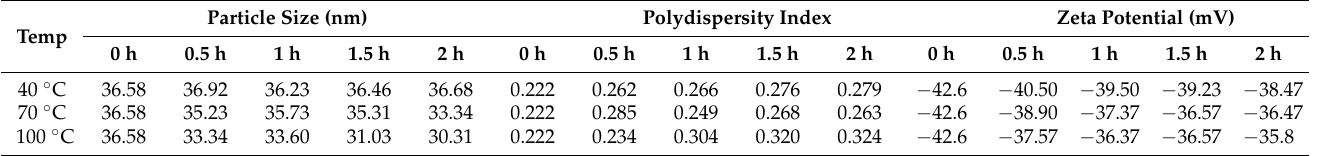
Table 7. The average particle size, polydispersity index and zeta potential changes in C. osmophloeum leaf nanoemulsion during storage for 90 days at 4 ◦ C and during heating at 40 ◦ C, 70 ◦ C and 100 ◦ C for varied time